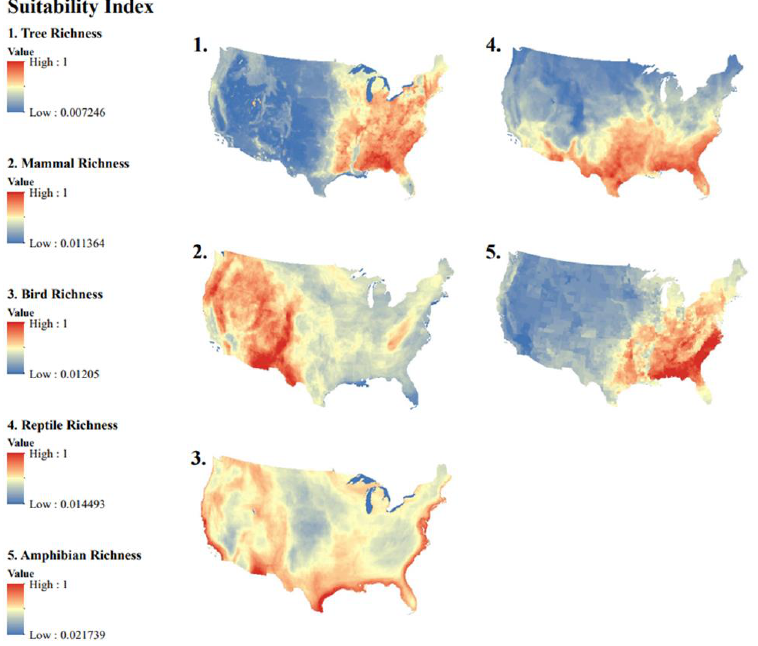
Figure 9. The national HS maps based on 1. tree richness, 2. mammal richness, 3. bird richness, 4. reptile richness, and 5. amphibian richness. Higher species richness values are shown as red and lower values in blue.